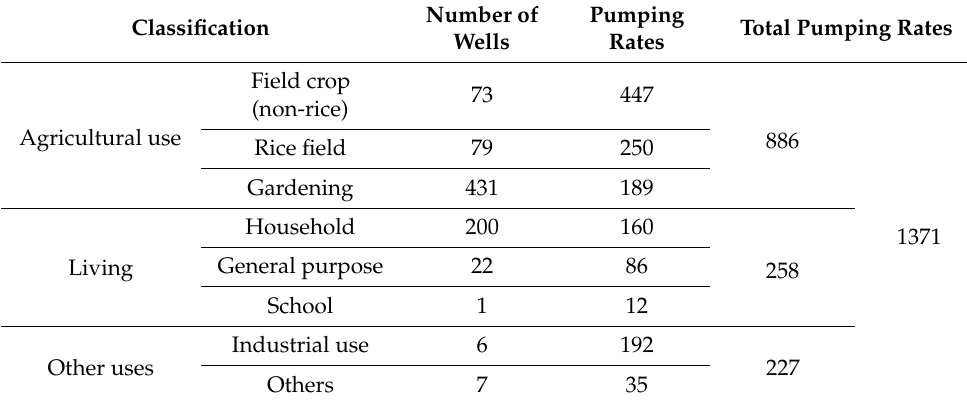
Table 1. Estimated groundwater pumping rates (m 3